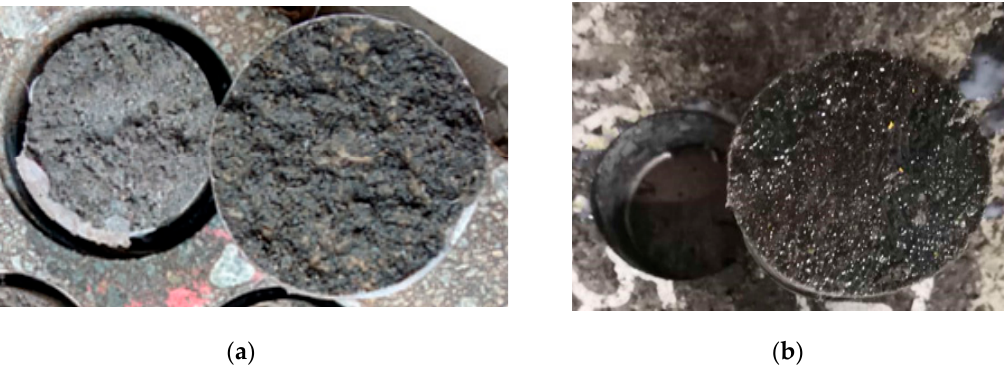
Figure 10. Interface states of specimen failure in the pull-off test: ( a ) the internal fracture of the concrete and ( b ) the interfacial fracture of the bonding layer.